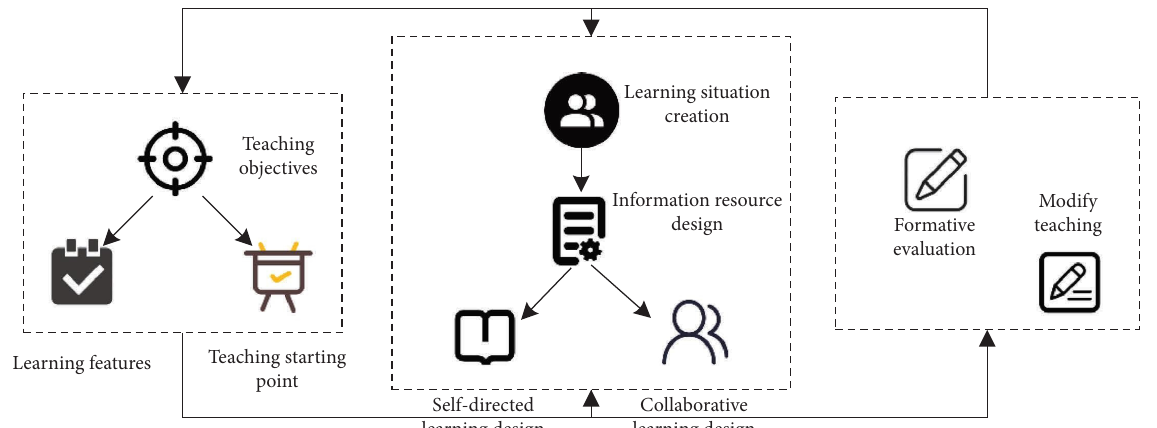
Figure 1: Te learning-centered teaching system design model based on